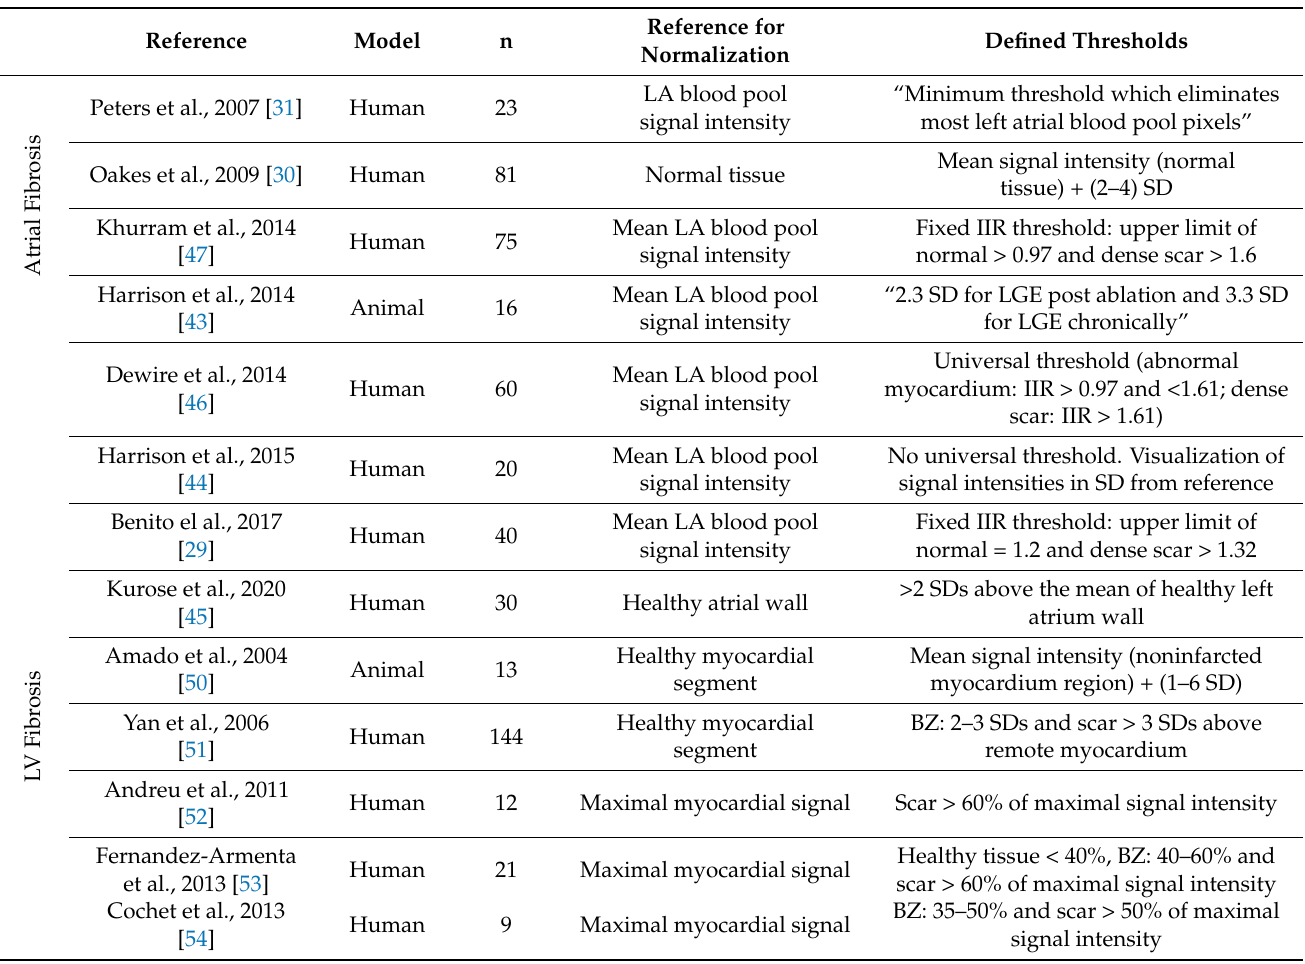
Table 1. LGE-MRI post-processing defining thresholds for fibrosis